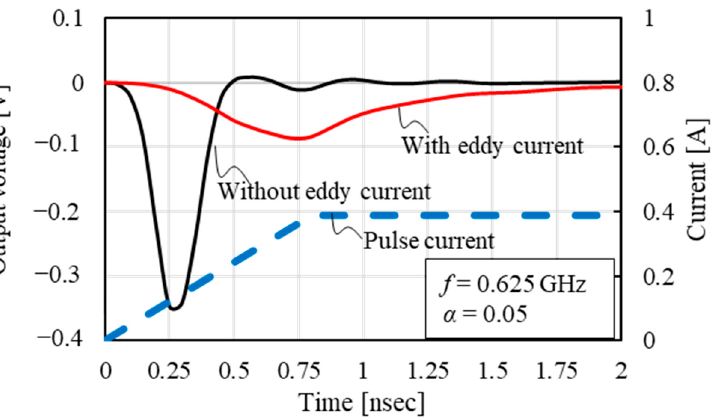
Figure 6. Comparison between output voltages at rise time of pulse current with and without eddy current. eddy